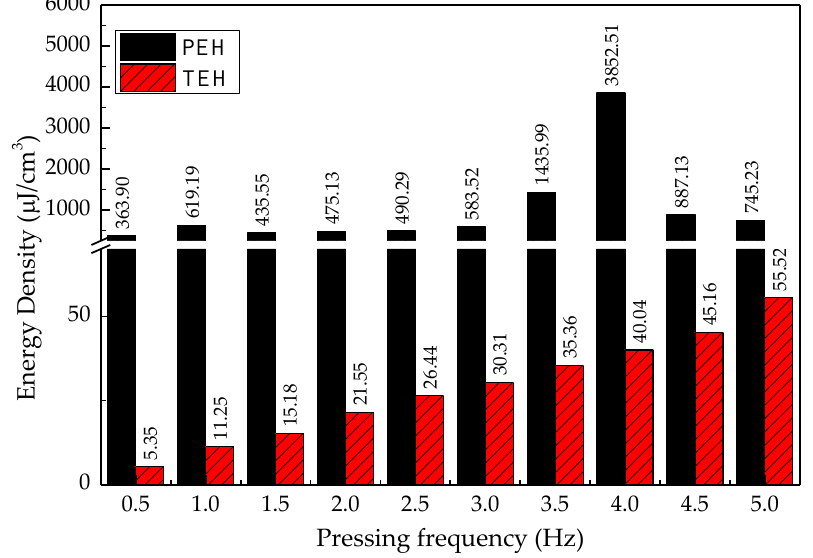
Figure 13. Energy densities of PEH and TEH under the variable pressing frequency of 0.5 – 5 Hz and at a 4 mm gap width.